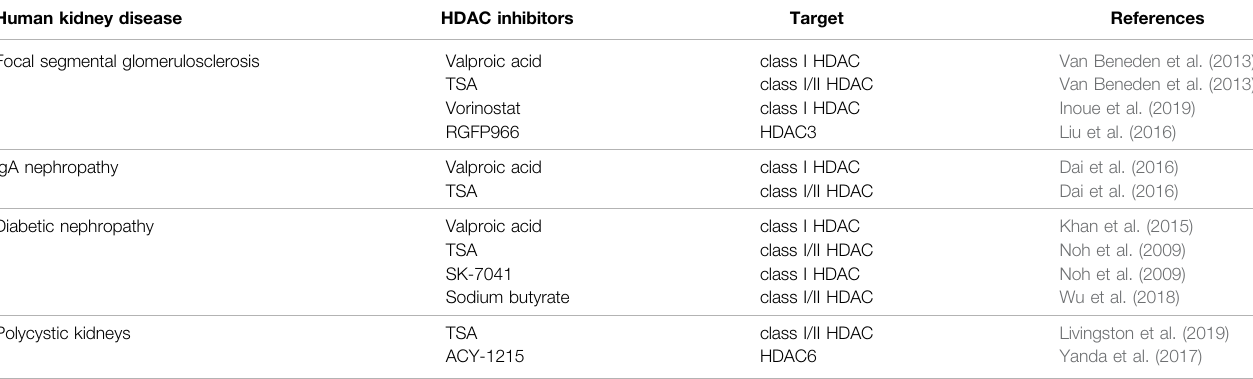
TABLE 4 | Expression of HDACs in human kidney